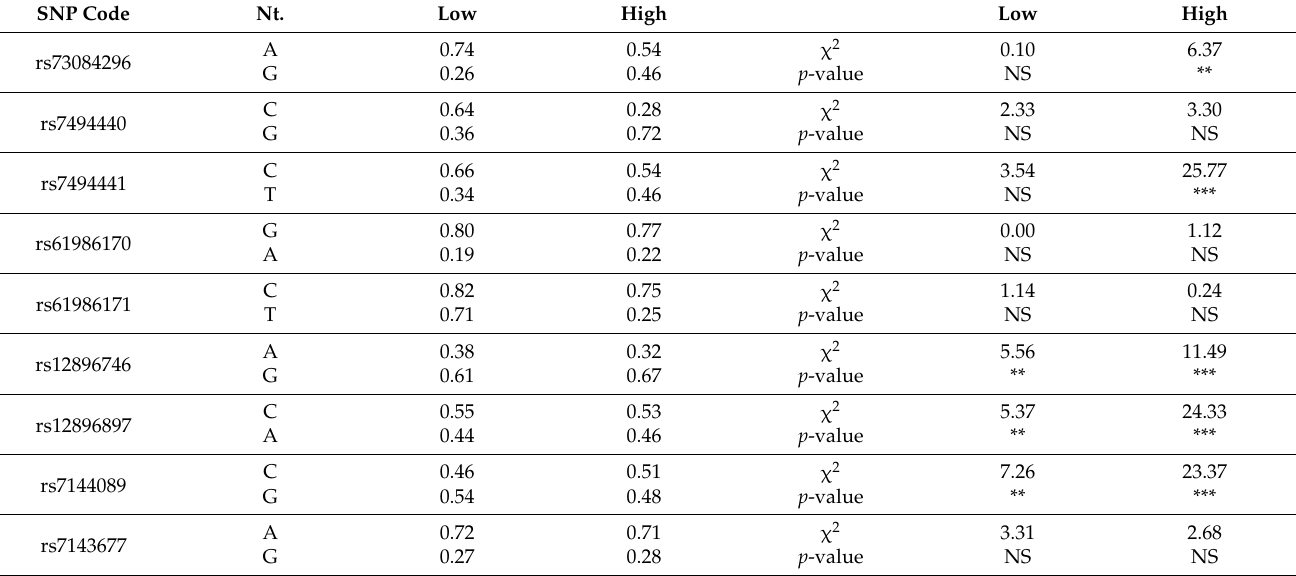
Table 2. Allele frequencies and distribution of detected 9 SNPs in seronegative individuals, lowly and highly responsive to the BNT162b2 vaccine. In the left side, the allele frequencies of detected 9 SNPs (rs373084296, rs7494440, rs7494441, rs61986170, rs61986171, rs12896746, rs12896897, rs7144089 and rs7143677) associated with the individuals with low and high antibody levels in response to the BNT162b2 vaccine are stated. In the right side, the chi-square ( χ 2 ) is reported, and P values are determined for the deviation from Hardy–Weinberg equilibrium in each cohort of individuals, as in Table 2A. Nt, nucleotide; ns, not significant; **, p < 0.01; ***, p < 0.001. Nt.